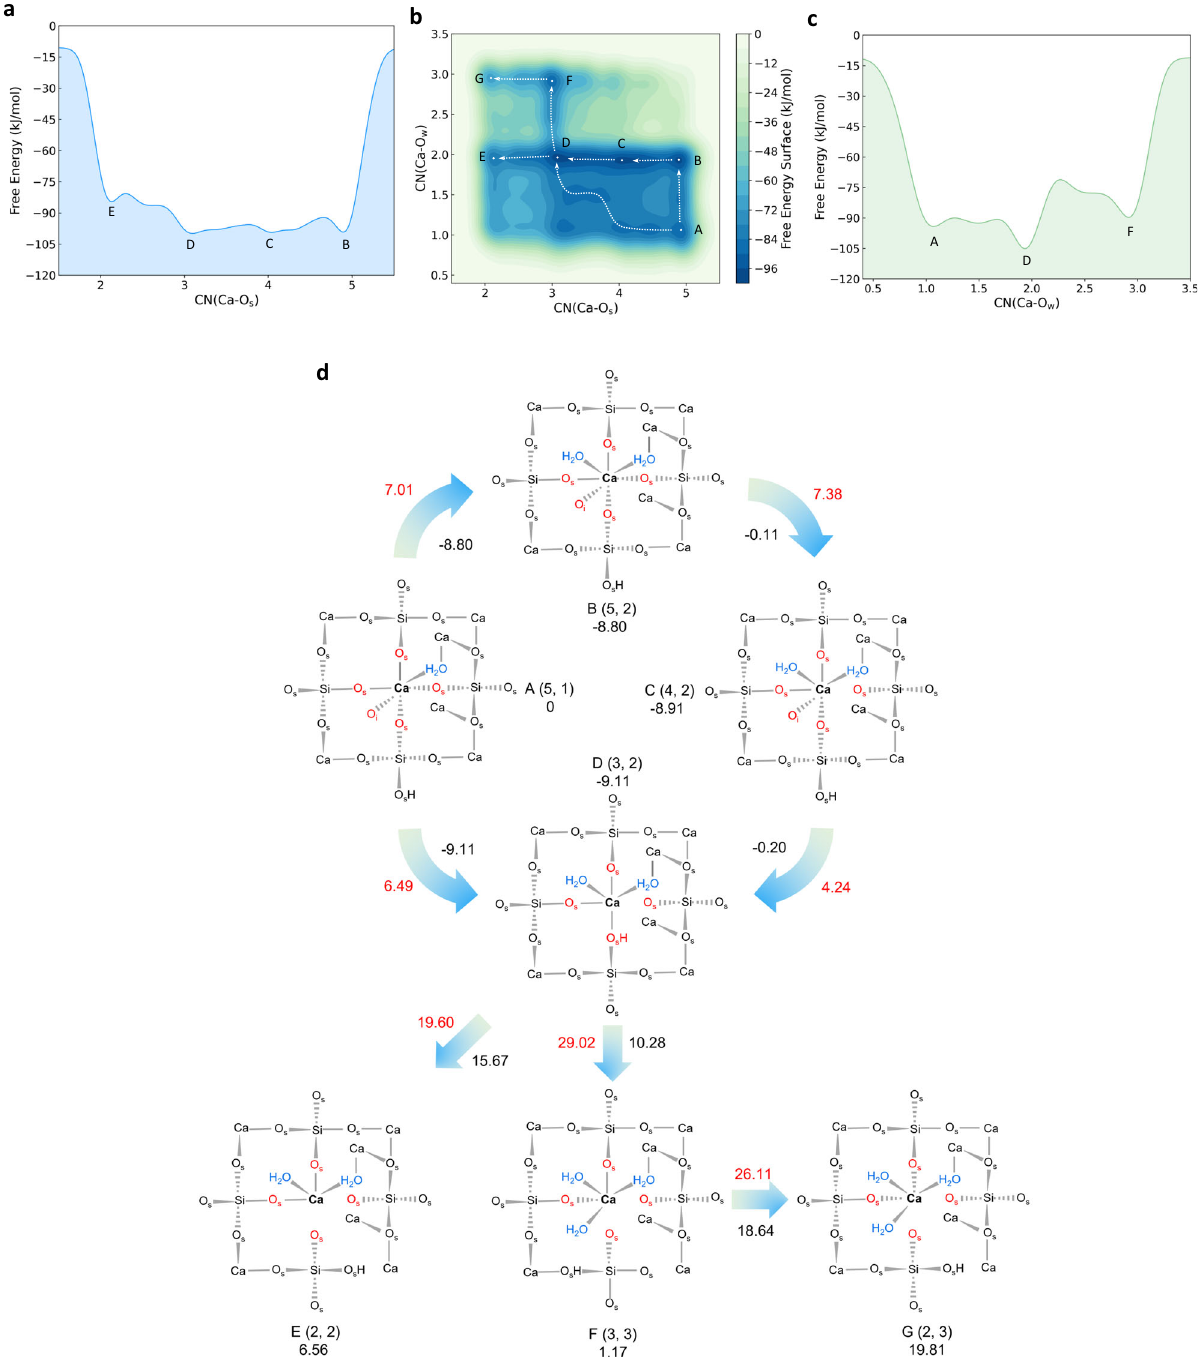
Fig. 3 Dissolution mechanism of Ca β from the Ca 3 SiO 5 surface with CN(Ca – O s ) from 5 to 2. a , c The one-dimensional free energy pro fi les with respect to CN(Ca – O s ) and CN(Ca – O w ), respectively. b The two-dimensional free energy surface with variables of CN(Ca – O s ) and CN(Ca – O w ). d The overhead sketches for the fi rst layer of the Ca 3 SiO 5 surface of the free energy minimum states on the FES (the all-atom con fi gurations is presented in Supplementary Fig. 1) and the corresponding reaction pathways. The state number, coordinates on the FES and the Helmholtz free energy values (kJ/mol) relative to state A are presented around the corresponding structure. The values in red are free energy barriers (kJ/mol) and the values under the arrows in black are overall changes in free energies between two states (kJ/mol). The biased Ca β is bolded, and the O s and O w bonded with Ca β were highlighted in red and blue,